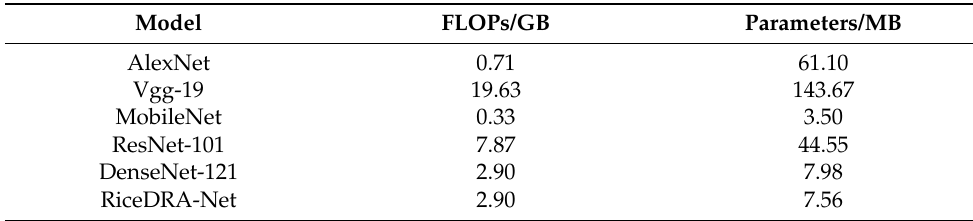
Figure 15. Average PR curves of six models using CBG-Dataset. Table 9. Comparison of Computational